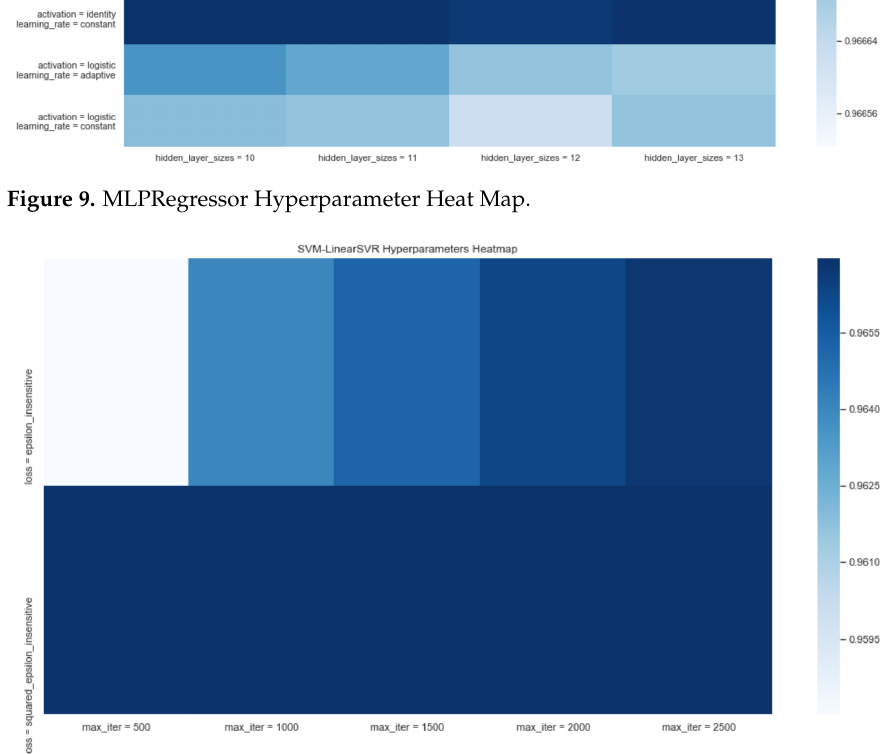
Figure 10. SVM-LinearSVR Hyperparameter Heat